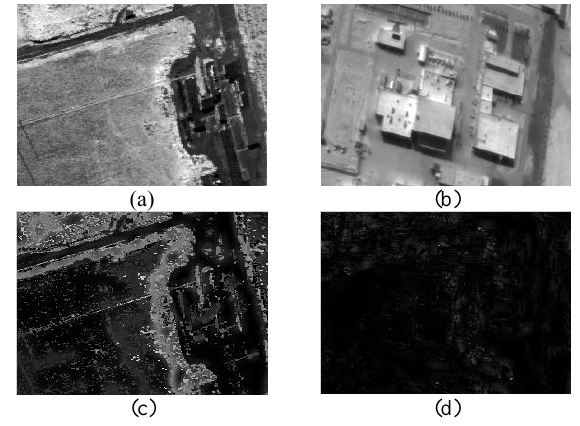
Figure 2. Example of morphological image normalization: a) image f ; b) image g ; c) image f normalized by self-shape F ( fPfP  ); d) image g normalized by shape F ( gPgP OF